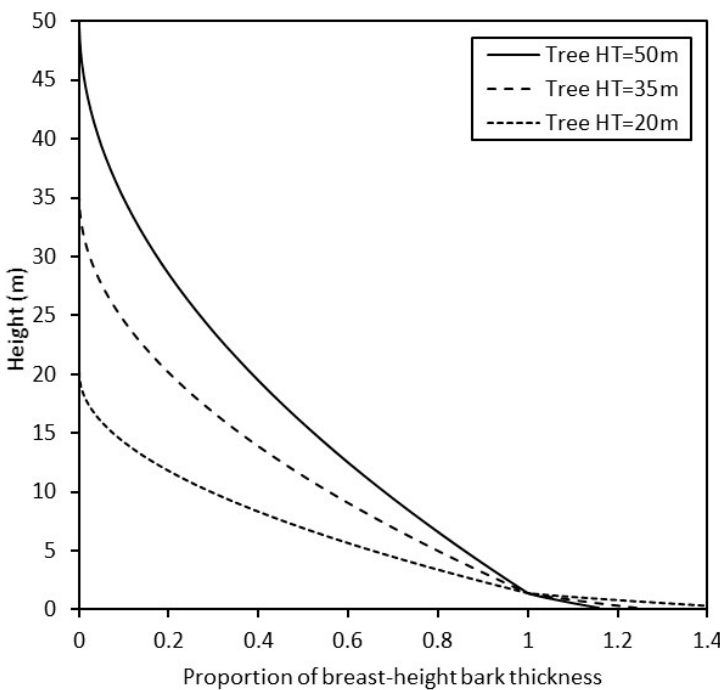
Figure 3. Modeled bark thickness (BT) tapering above and below the breast height (1.37 m) for three redwood trees of different heights: 50 m, 35 m, and 20 m total height.